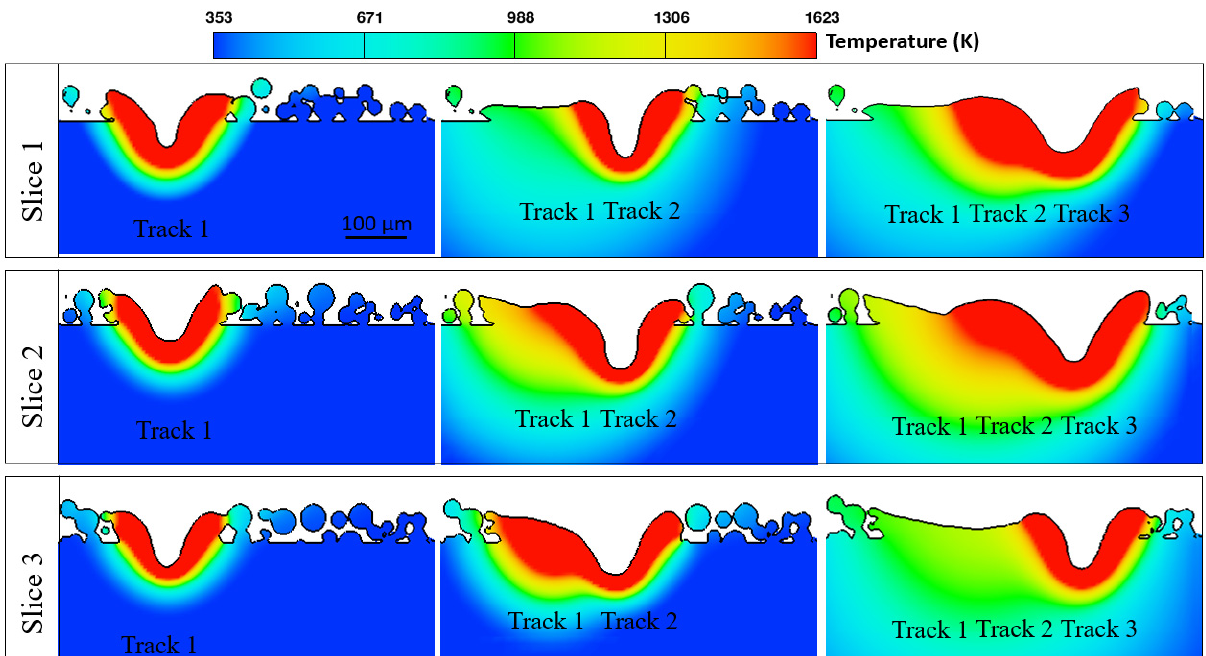
Figure 13. Temperature contours to observe the melt pool at different locations.